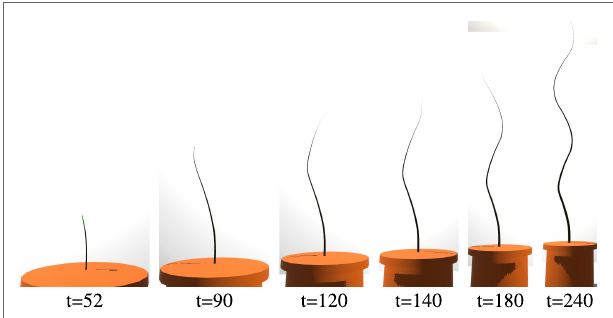
FigUre 6 | Screenshots of a swarm grammar specifically illustrating phototropic growth over time. Two light sources at the top-left and top-right are alternately activated to guide the movement of the tip and thereby influence the shape of the stem.